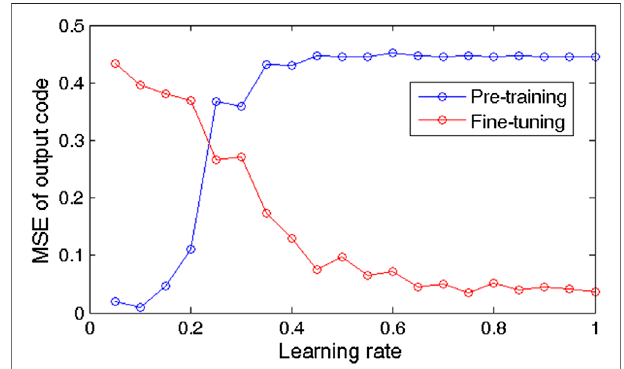
FIGURE 13 | MSE curves of different numbers of learning rate.